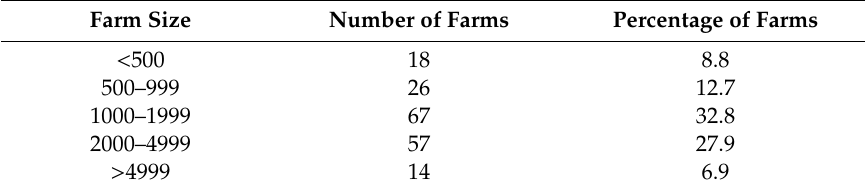
Table 1. Distribution of farm size according to number of finisher places.